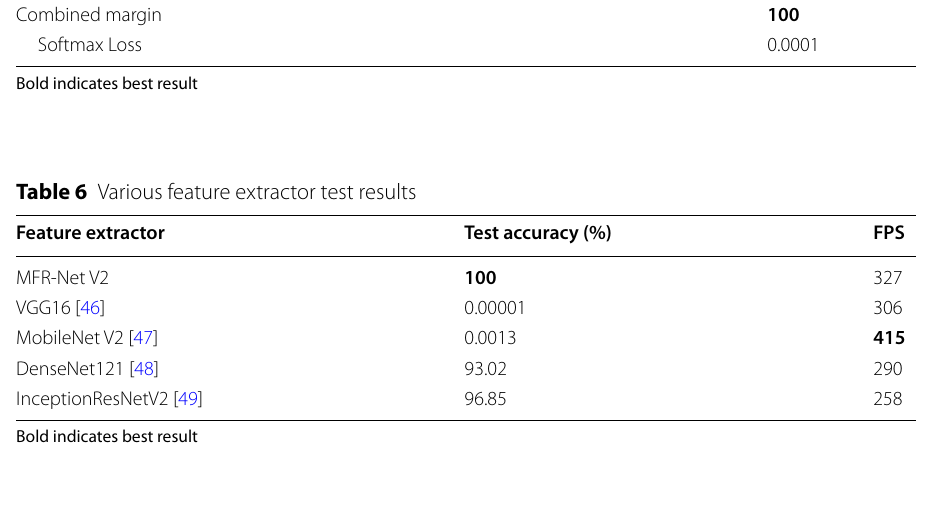
Bold indicates best result